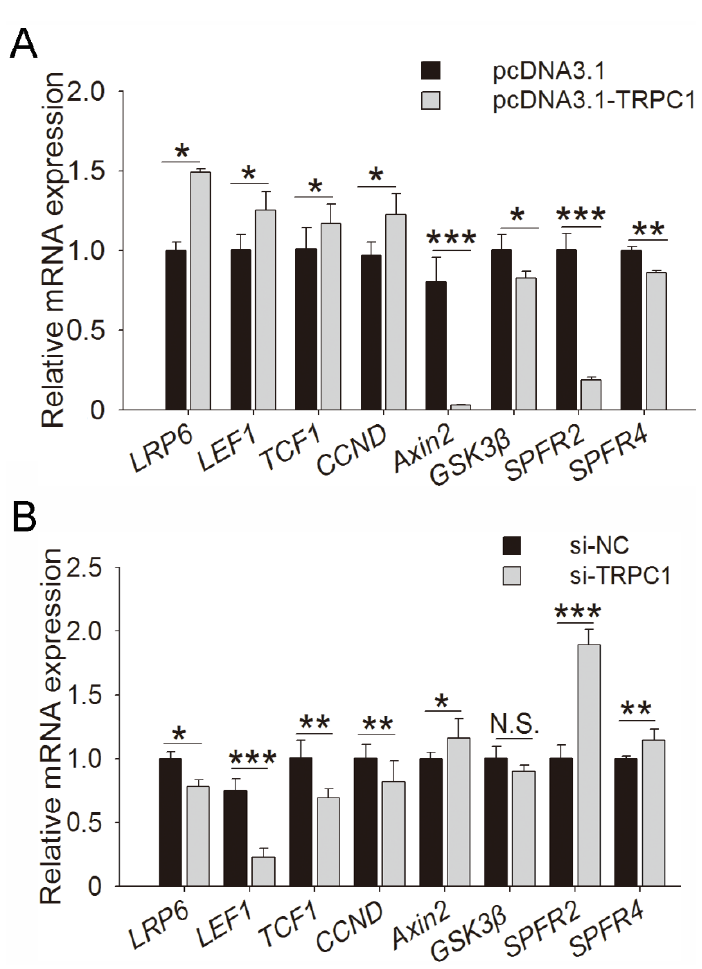
Figure 5. Regulation of TRPC1 in myogenesis. The mRNA expression of Wnt-related genes in C2C12 cells in which TRPC1 was overexpressed ( A ) or knocked down ( B ), respectively. NC: negative control. The data represent the means ± SD of three independent experiments. N.S.: not significant, * P < 0.05, ** P < 0.01, *** P < 0.001.